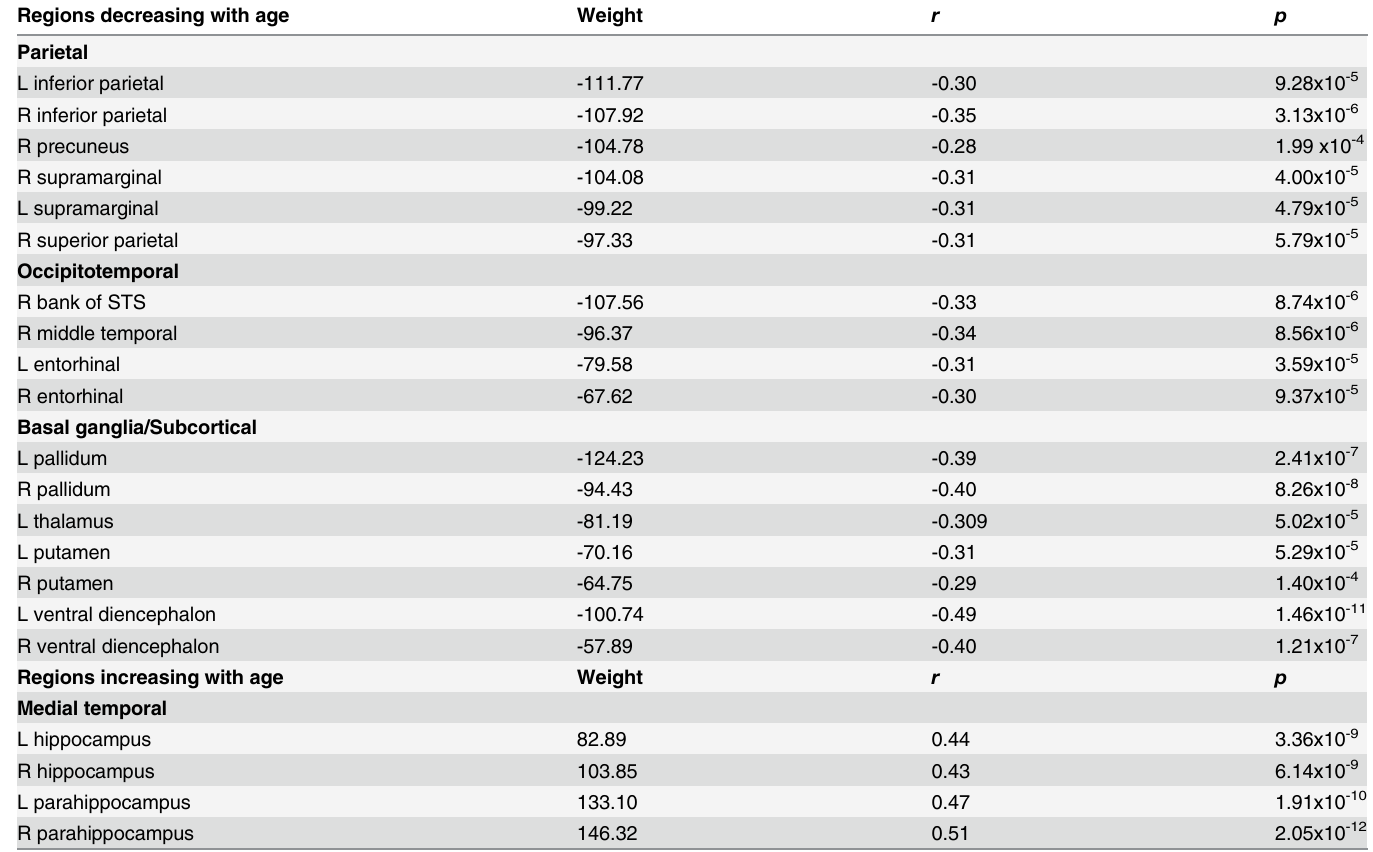
Table 1. Magnitude of developmental